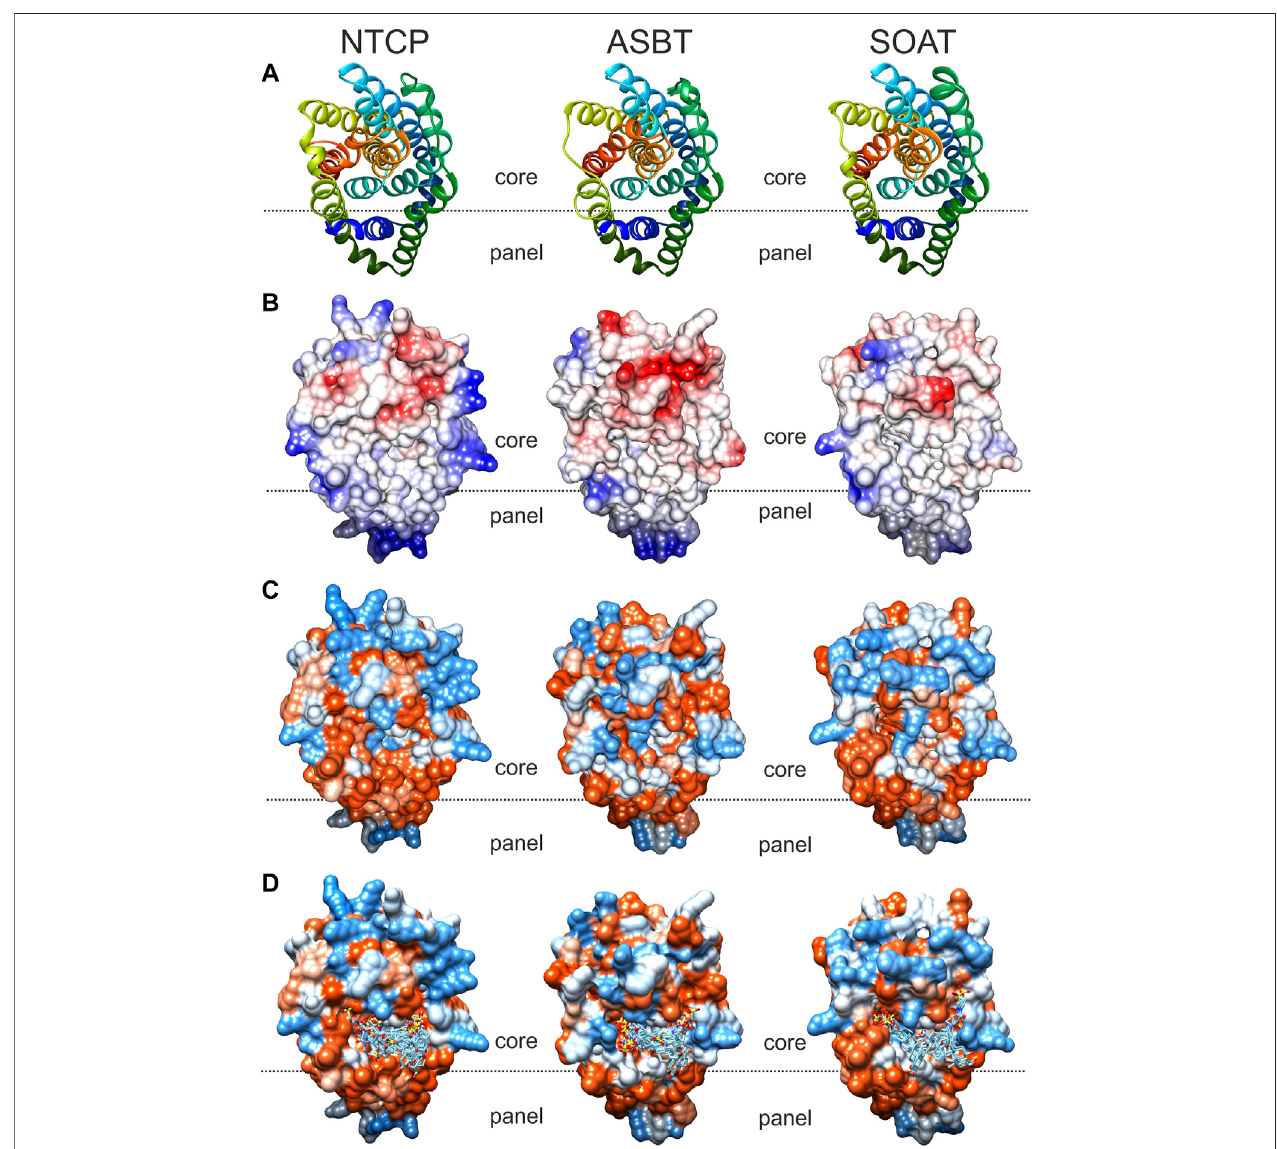
FIGURE 6 | Comparative substrate docking to homology models of NTCP, ASBT, and SOAT in outward-open conformation. Based on the crystal structure of bacterial Asbt Yf (4n7x.1.a) outward open homology models of the SLC10 transporters NTCP, ASBT and SOAT were generated with SWISS-MODEL. All models are shown in identical orientation in top view. The dotted line gives an orientation for the localization of the proposed substrate-binding cavity between the panel and core domains of the respective carrier. (A) Backbone structure colored in rainbow-mode to depict similar transmembrane structure. (B) Molecular surface colored due toCoulomb forcecalculation(electrostatic forces); startingfrom − 10(red),over 0(white),upto+10(blue). (C) Hydrophobicity surfacecoloringdue toaminoacidresidue sequence hydrophobicityranging fromhydrophilic(blue) over neutral (white) to lipophilic(red). (D) Insilico docking ofTLC bySwissDock. Dockedclusterswerereduced to TLC molecules in reasonable proximity to the putative outward facing binding pocket. All models were visualized with the UCSF CHIMERA software.